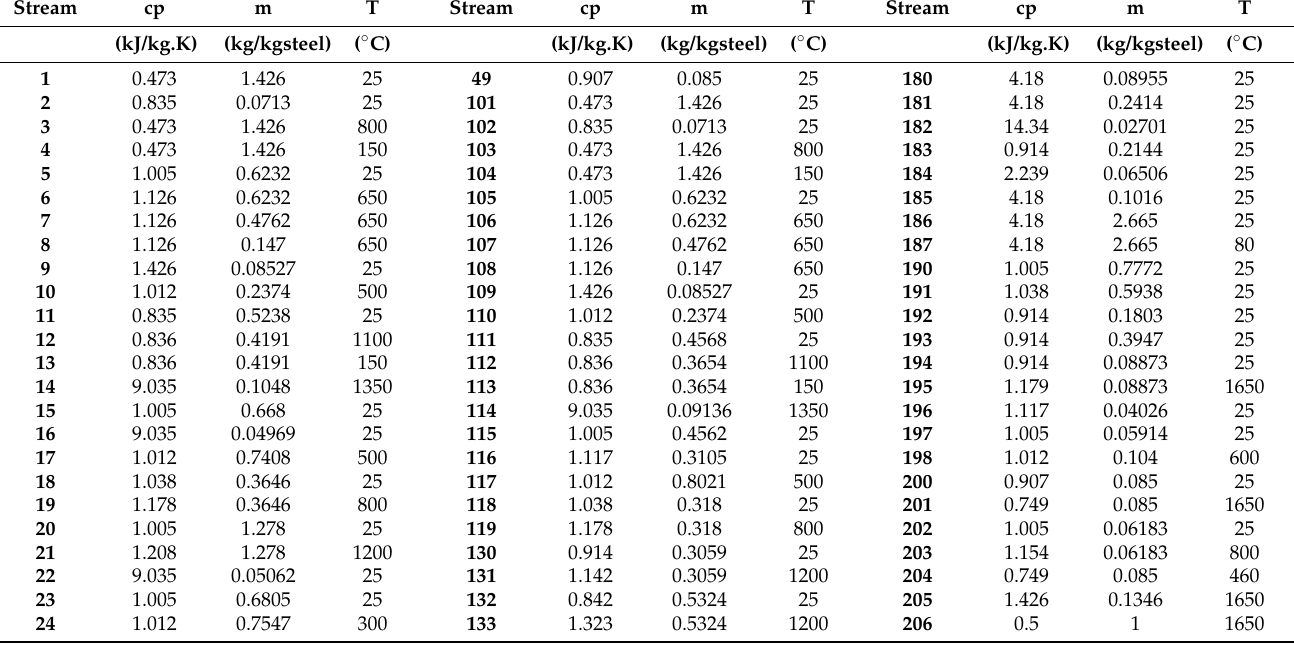
Table 1. Specific heat, mass flows, and temperatures for Cases 0, 1 and